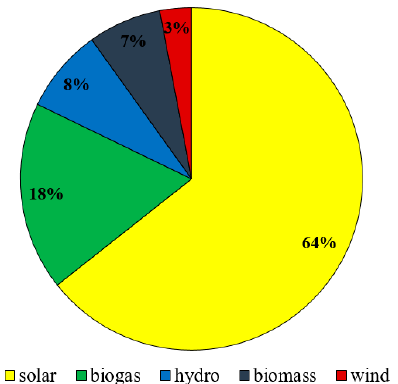
Figure 2. The structure of renewable energy installations according to the number of installations in major Polish cities. Source: own study based on data from the Energy Regulatory Office (ERO) [85].